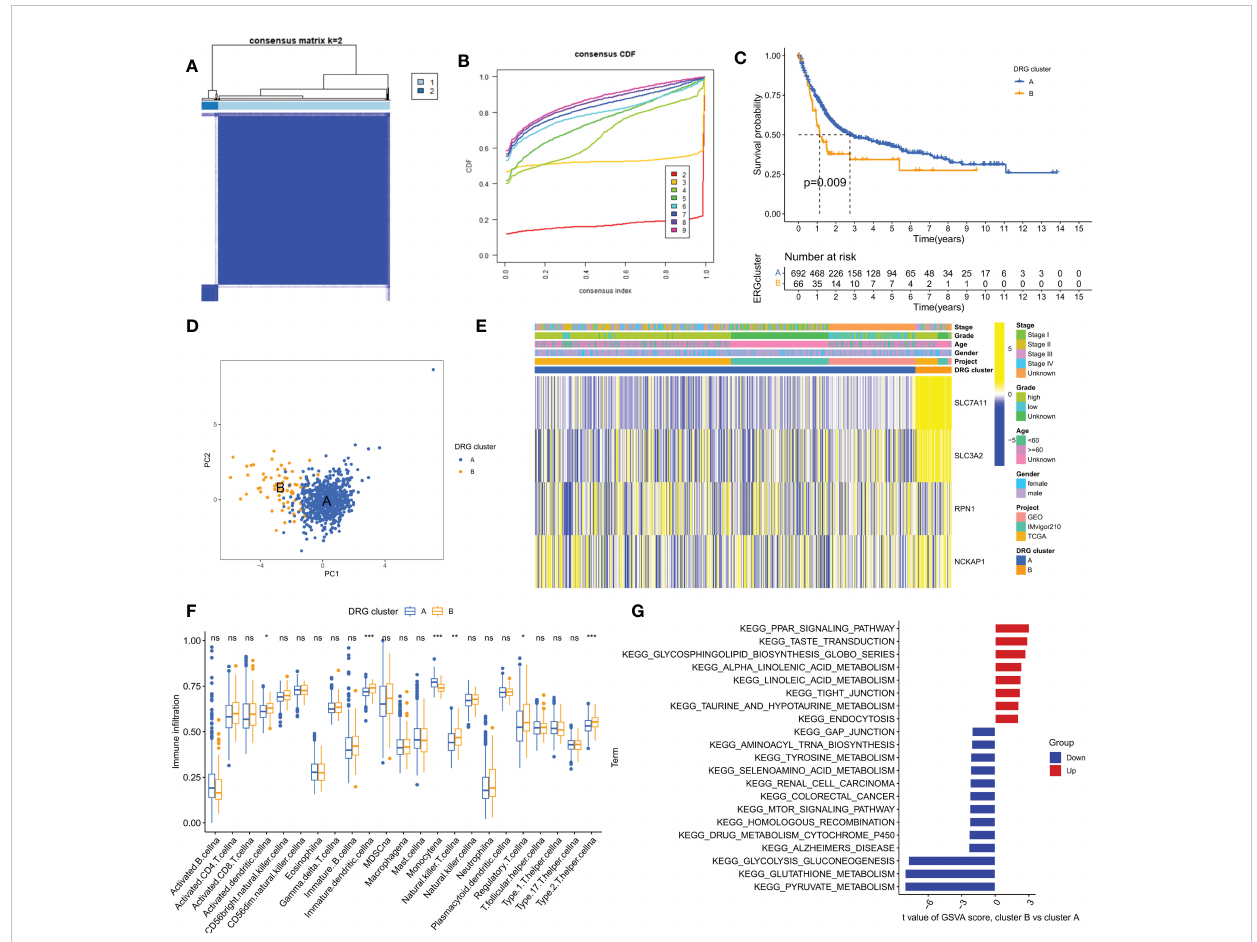
FIGURE 3 Clinical, pathological, and biological characteristics of two DRG clusters. (A) All samples from the TCGA-BLCA, iMvigor210, and GSE13507 cohorts were divided into two clusters using a consensus clustering algorithm (k=2). (B) Cumulative Distribution Function (CDF) from k=2 to 9. (C) Kaplan- Meier curve shows different overall survival (OS) between the two DRG clusters. (D) Principal Component Analysis (PCA) shows signi fi cant differences between the two DRG clusters. (E) Heatmap shows differences in clinical information and DRG expression between the two DRG clusters. (F) Abundance of 23 in fi ltrating immune cells in the two DRG clusters. (G) GSVA of biological pathways between the two DRG clusters. ns, no signi fi cance,*p< 0.05, **p< 0.01, ***p<